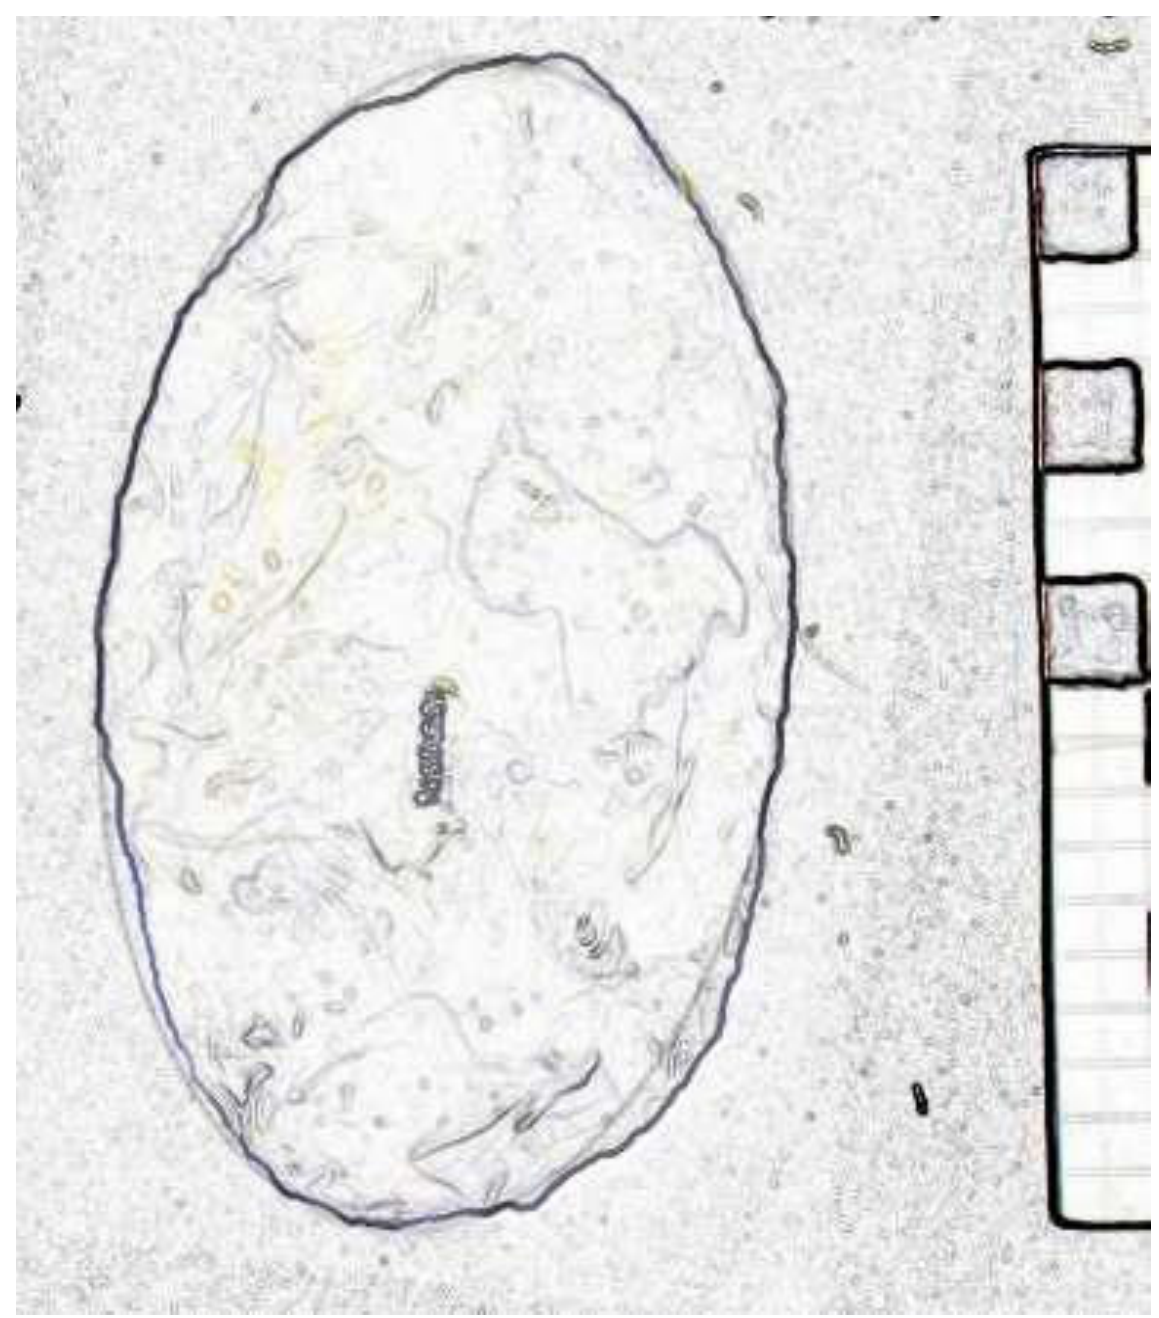
Figure 2. Specimen BD